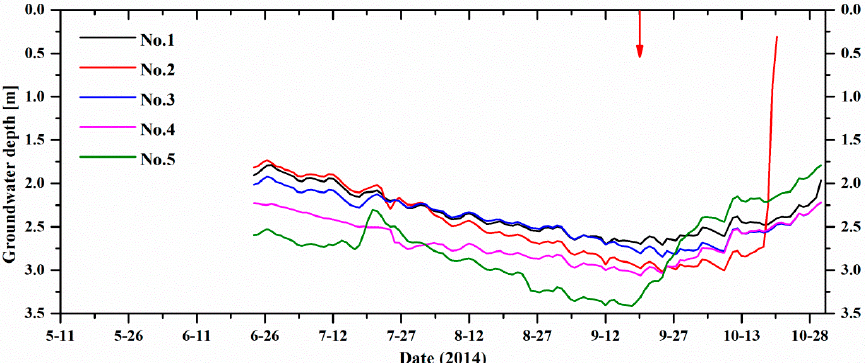
Figure 9. Temporal variation in the measurements of groundwater depth at five observation wells. The red arrow represents the replenishment of groundwater by the surface water from the Heihe River.